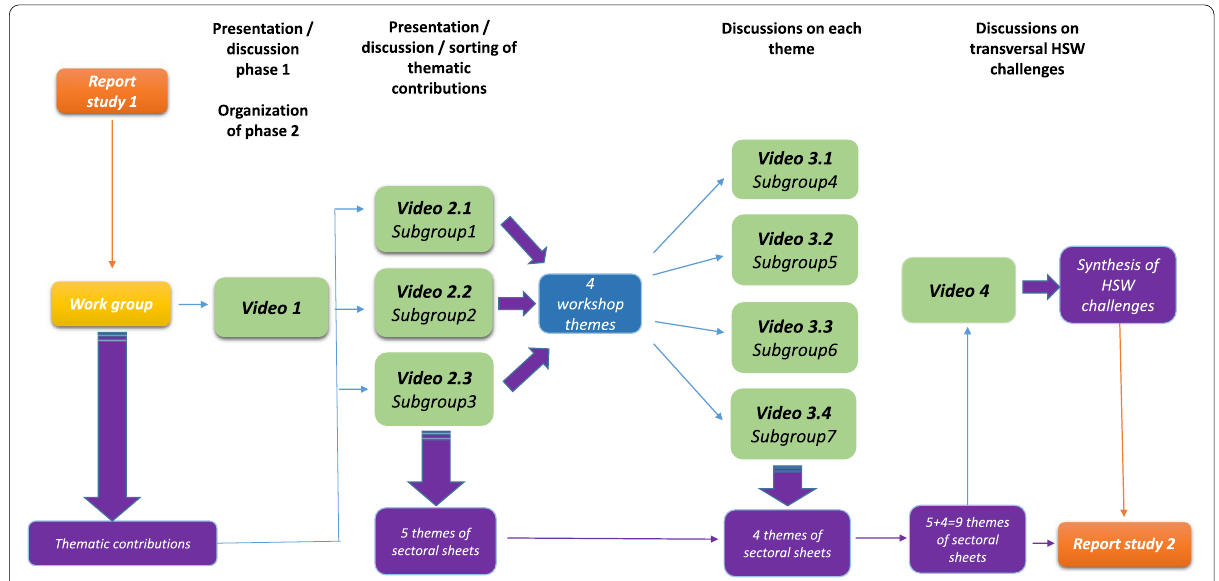
Fig. 2 Diagram of the working method — second